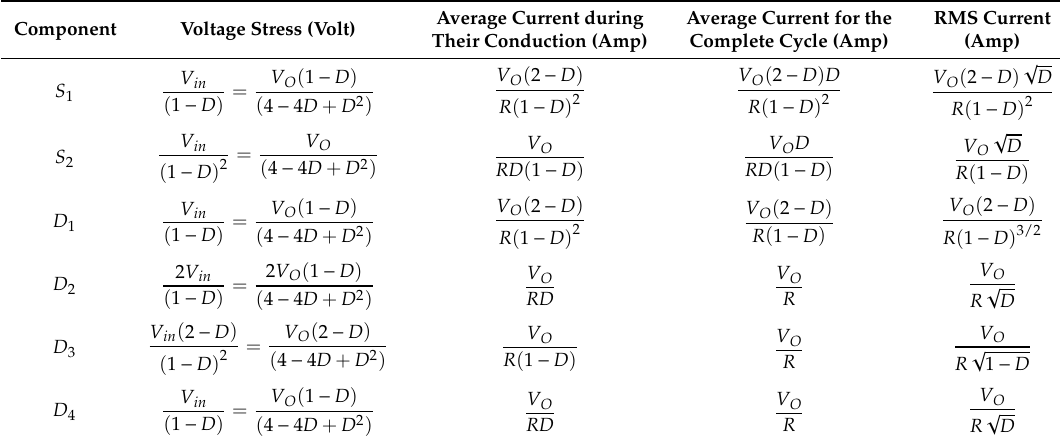
Table 1. Voltage stress and current across the switches and